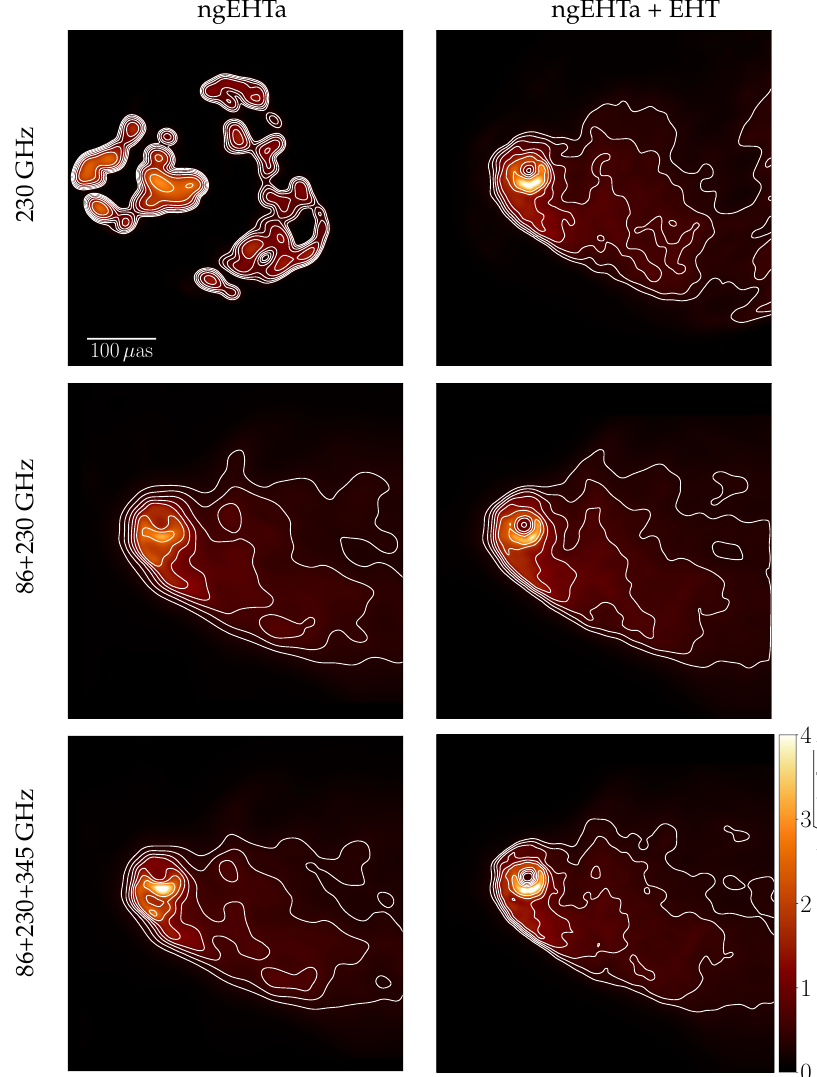
Figure 1. Demonstration of multi-frequency capabilities with simulated observations of the M87 jet at 230GHz reconstructed with and without 86 GHz complementary observations. The left column shows reconstructions using the new ngEHTa configuration stations alone (see Section 3.1 for array specifications), and the right column shows reconstructions with the full ngEHT array, including the core EHT stations. Top: Simulated reconstructions of 230GHz only observations. The contours are spaced logarithmically, starting at 1% of the peak value and increasing by factors of 2. Middle: Simulated reconstructions at 230 GHz using multi-frequency 86 and 230 GHz observations. Bottom: Simulated reconstructions at 230GHz using multi-frequency 86, 230 and 345GHz observations. This demonstration offers a compelling view of the imaging advantages of adding 86GHz receivers to the ngEHT, enabling flexible high-fidelity imaging of the black hole shadow and jet during times when the core EHT sites would not be readily